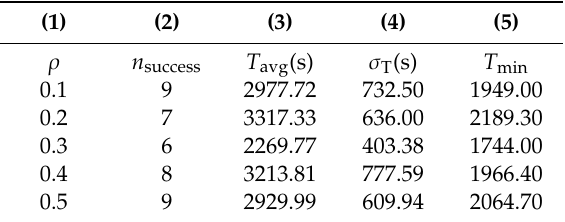
Table 2. Simulation results for various evaporate constants at t occ > 150